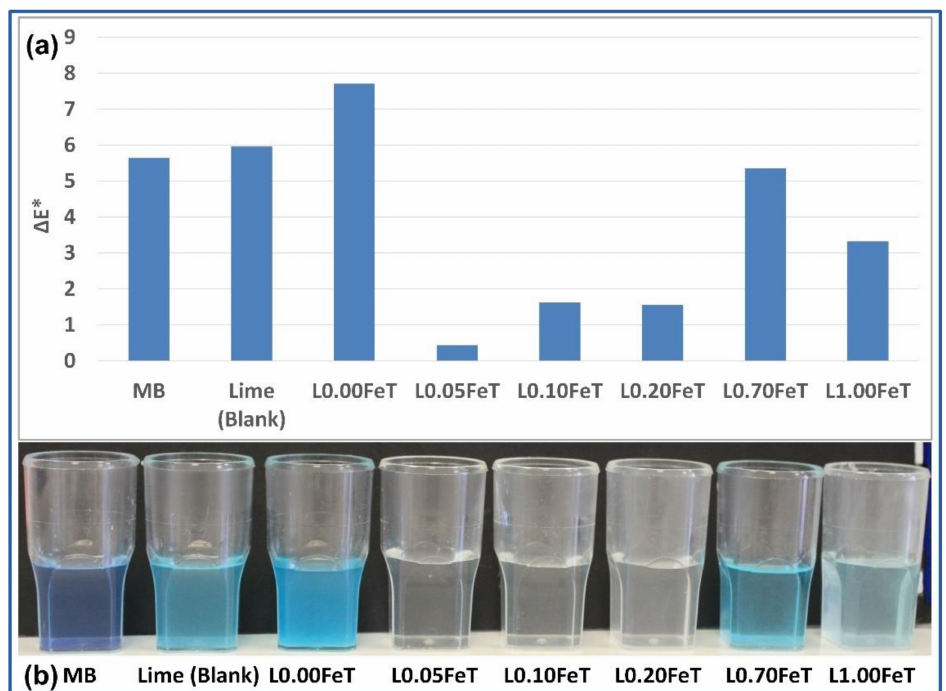
Figure 7. Total color di ff erence ∆ E* of methylene blue (MB) in lime pastes containing doped and undoped TiO 2 ( a ) and the corresponding images of samples after 7 days under solar irradiation ( b